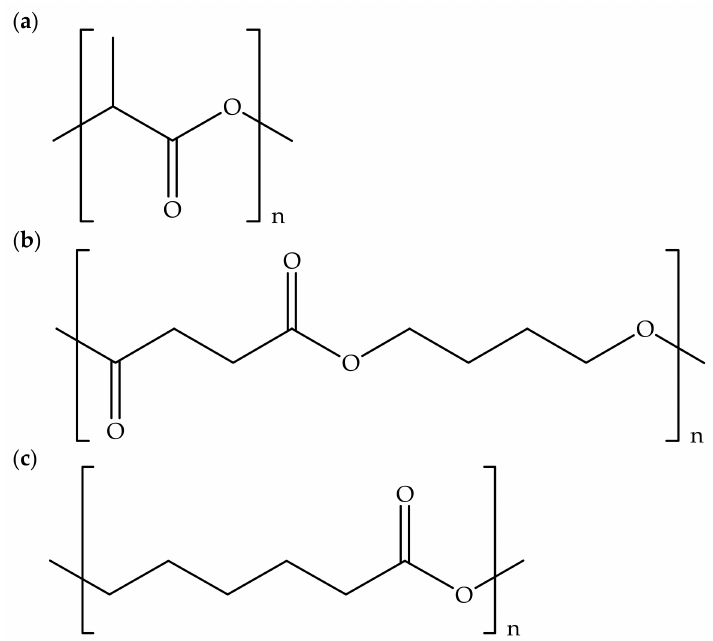
Figure 2. Chemical structures of ( a ) PLA, ( b ) PBS, and ( c )